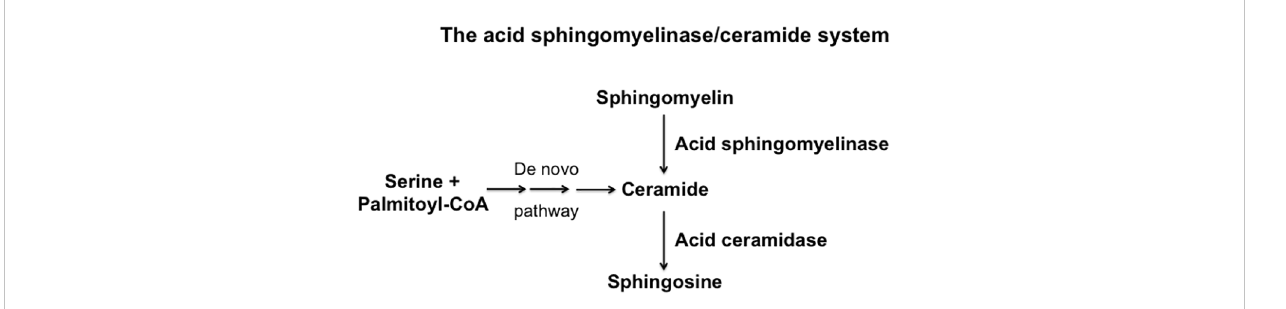
FIGURE 2 Schematic overview over the synthesis and consumption of ceramide, sphingomelin and